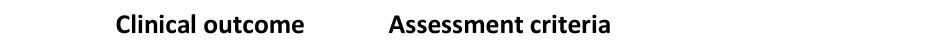
Table 2 Standardised clinical descriptors for assessment of lamb health and morbidity (secondary outcome) scored on binary scale